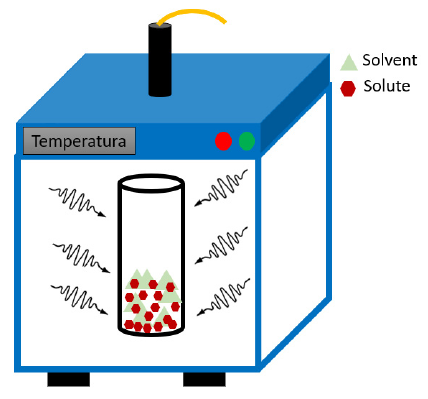
Figure 3. Scheme of microwave reactor for MAE.